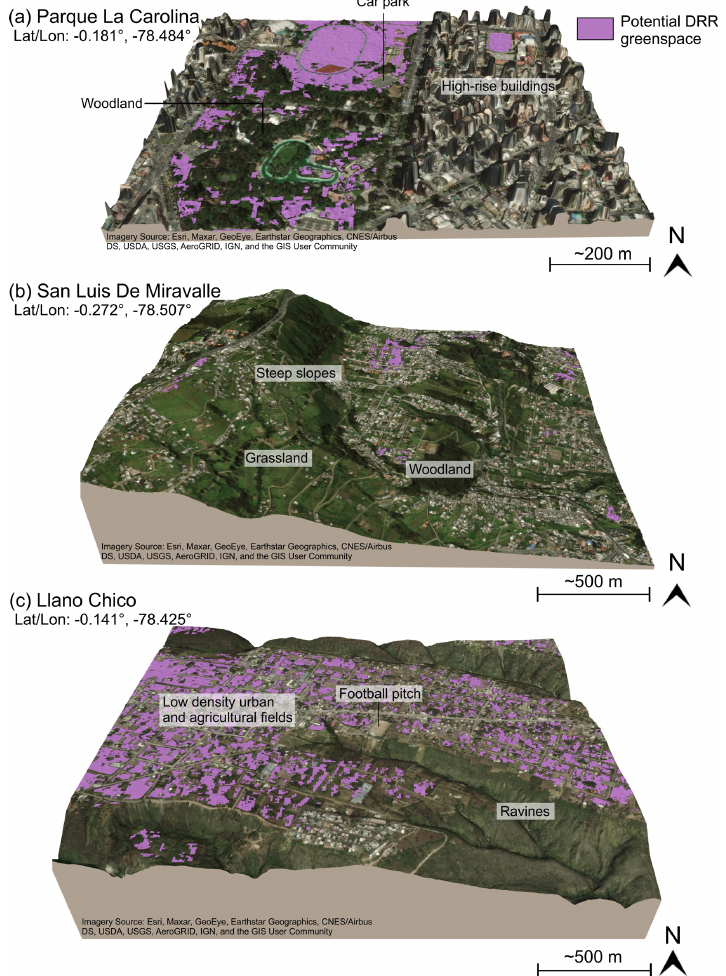
Figure 12. 3D perspective showing examples of potential DRR greenspace identified in Quito. (a) Parque La Carolina is in central Quito amongst commercial high-rise buildings. (b) San Luis De Miravalle is located on the southeast of Quito and is characterised by lower-density urban development and steep slopes. (c) Llano Chico is in the east of Quito with low-density urban development mixed with agricultural land that is bounded by steep